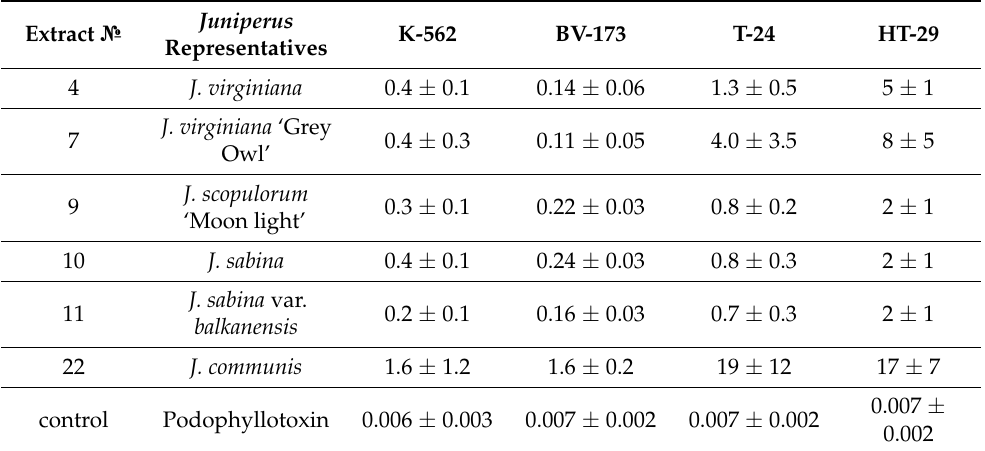
Table 5. Antiproliferative activity presented as IC 50 values [ µ g/mL] of the corresponding cytotoxic juniper leaf extracts after treatment of a panel of cancer cell lines. Extract